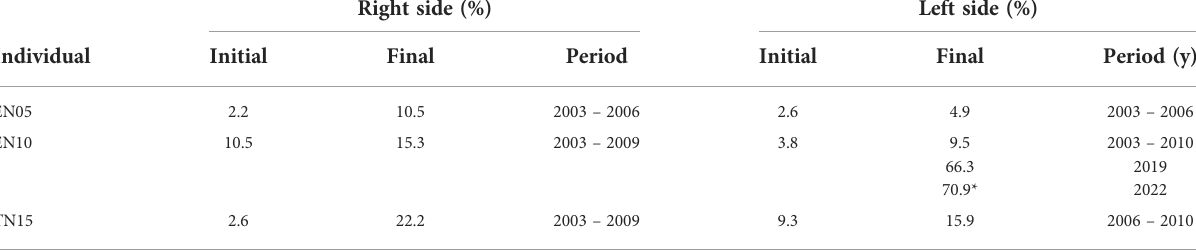
TABLE 2 Temporal progression of gross skin lesions (%) linked to LLD in dorsal fi ns of photo-identi fi ed bottlenose dolphins from Alvarado area. Right side (%) Left side (%) Individual Initial Final Period Initial Final Period (y)